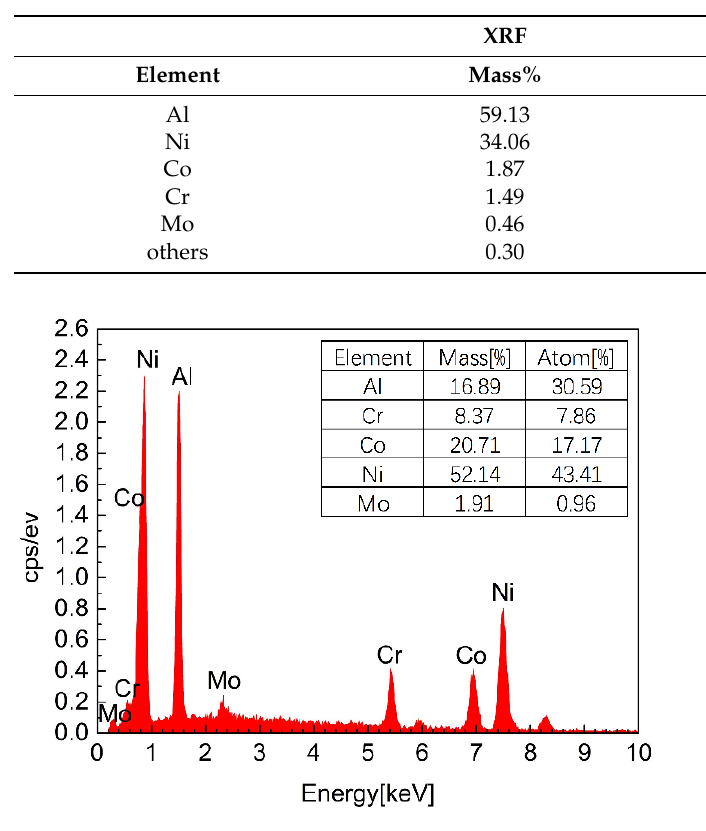
Figure 6. SEM images of batch 3 after leaching in 5 mol/L NaOH at different temperatures for dif- ferent times. ( a ) 40 °C for 6 h. ( b ) 40 °C for 12 h. ( c ) 40 °C for 18 h. ( d ) 80 °C for 12 h. Table 3. Element mass percentages of batch 3 determined by XRF analysis. Table 3. Element mass percentages of batch 3 determined by XRF analysis.